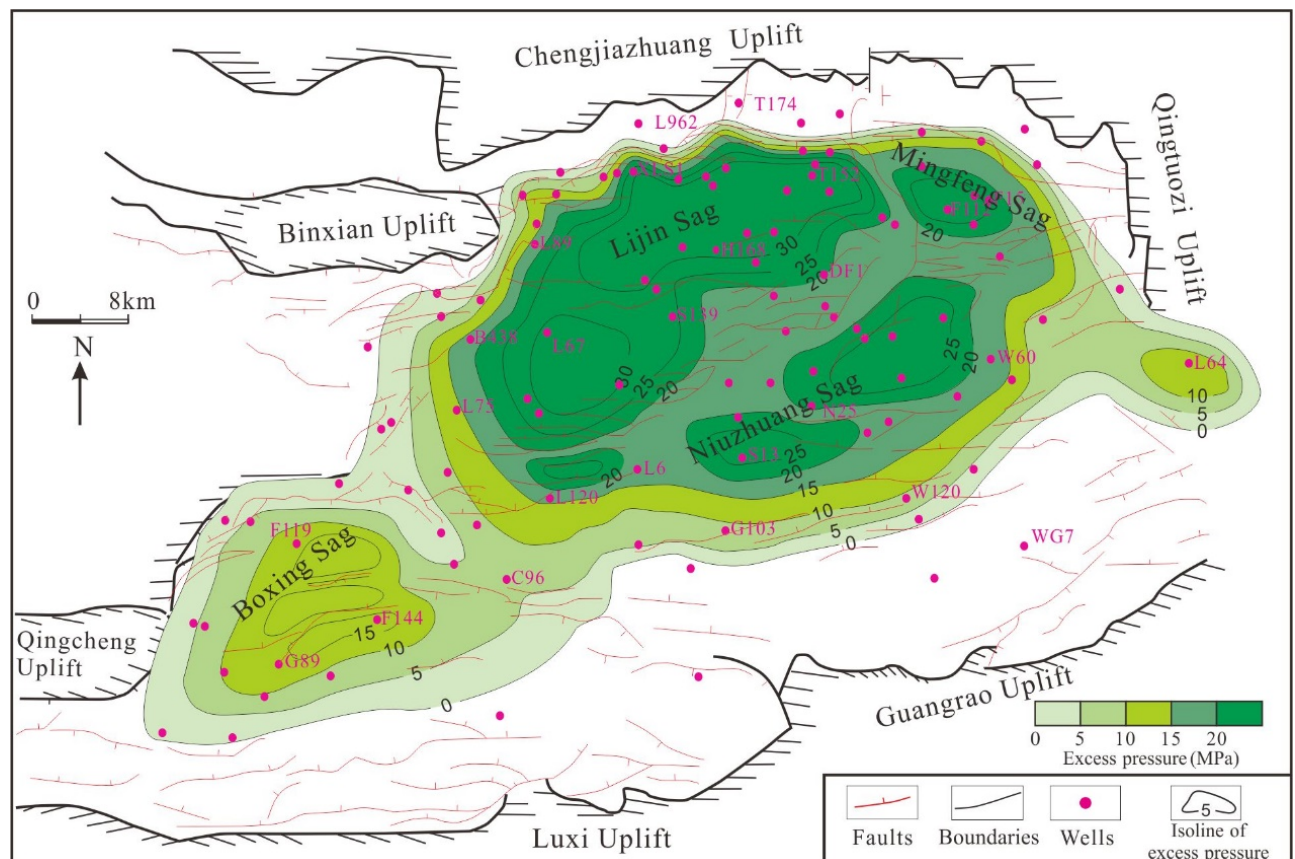
Figure 8. Contour map of plane distribution of maximum excess pressures in the upper interval of Es4 member of Dongying Depression.